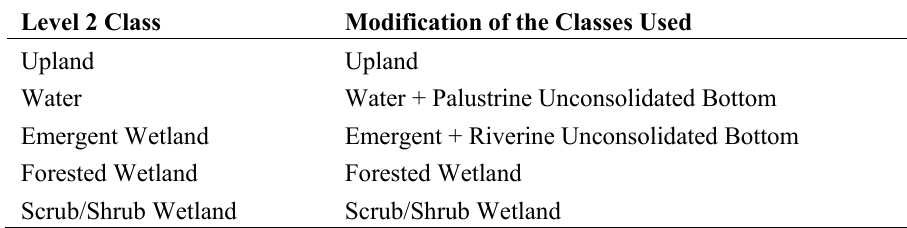
Table 1. Level 2 classification and our corresponding class